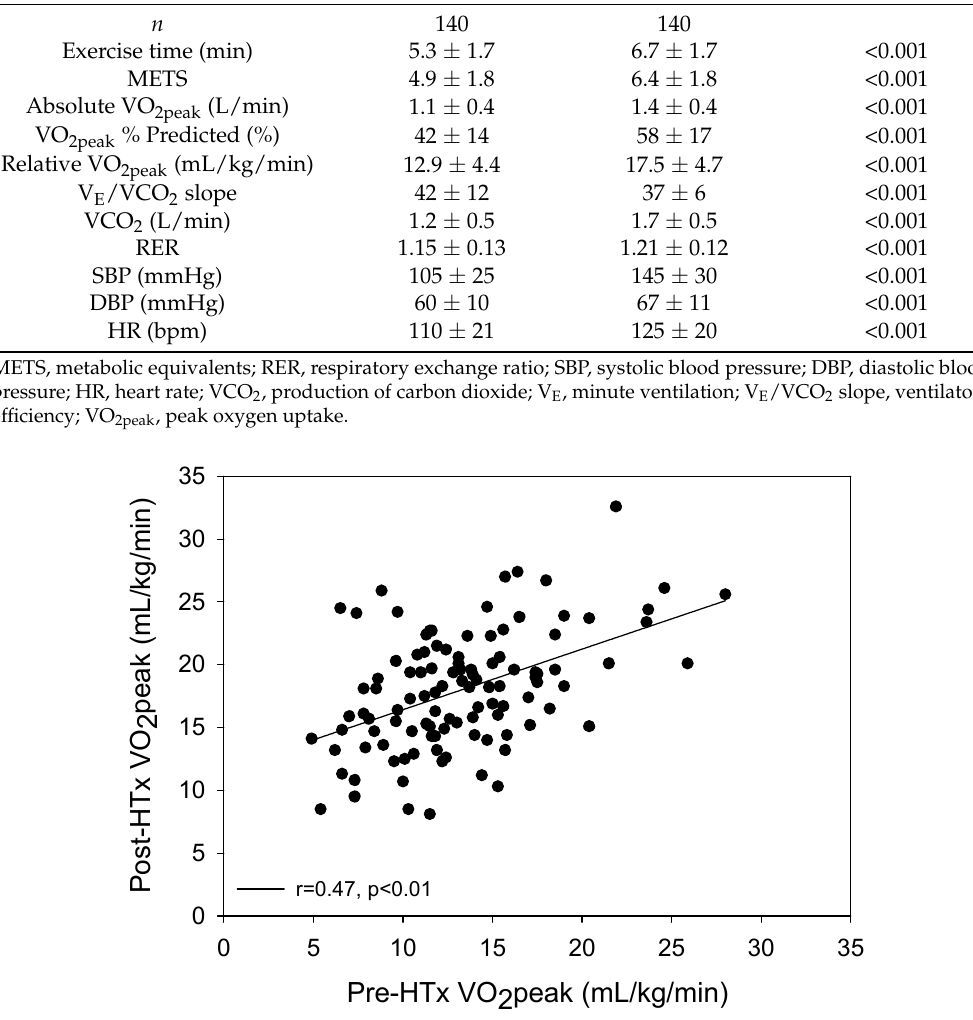
Figure 2. Relationship between measurements of relative VO 2peak from pre-HTx to post-HTx. A significant positive correlation was present between pre-HTx VO 2peak and post-HTx VO 2peak ( r = 0.47, p < 0.01). Post-HTx: following cardiac transplantation; Pre-HTx: prior to cardiac transplantation;